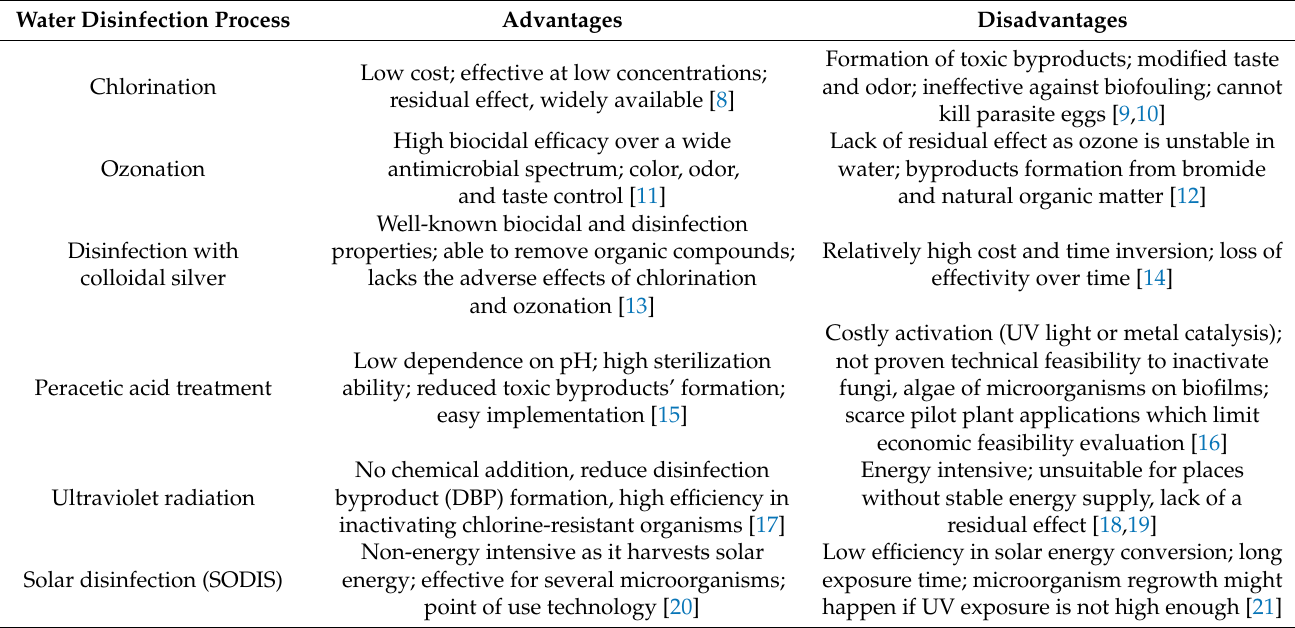
Table 1. Advantages and disadvantages of some of the most used water disinfection